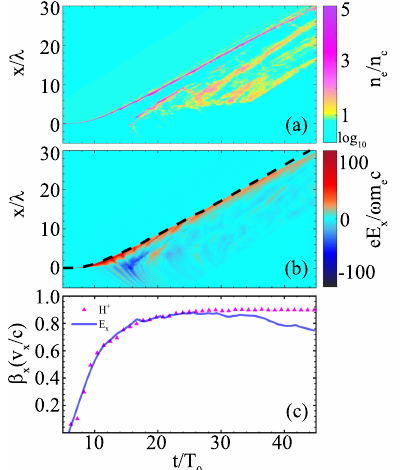
Figure 4. Temporal evolutions of ( a ) electron density n e and ( b ) longitudinal electric field E x . ( c ) Tem- poral evolution of the propagating velocities of the longitudinal electric field E x (blue line) and the velocities (pink triangles) of the proton energy peak. Trajectory of a typical proton is plotted by black dotted line in ( b ). The simulation parameters are the same as those in Figure